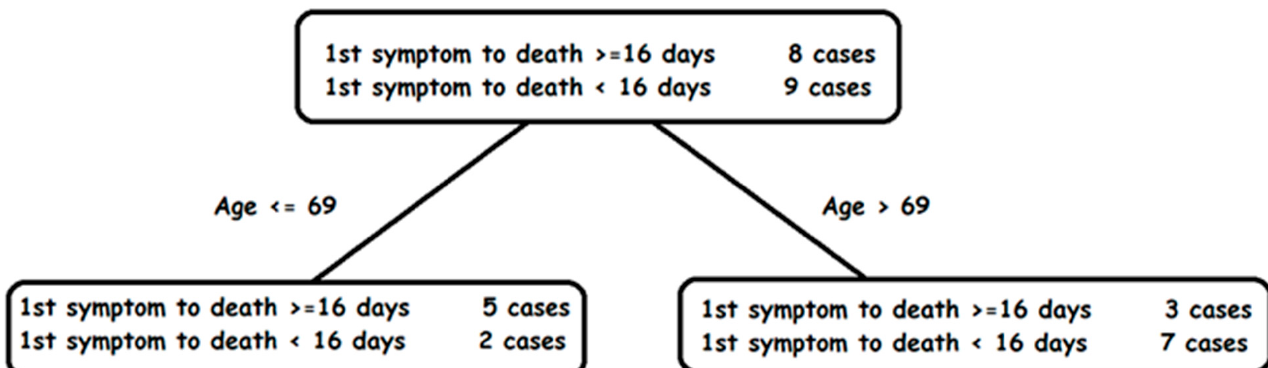
Figure 13. Decision tree obtained from the scatter graph.